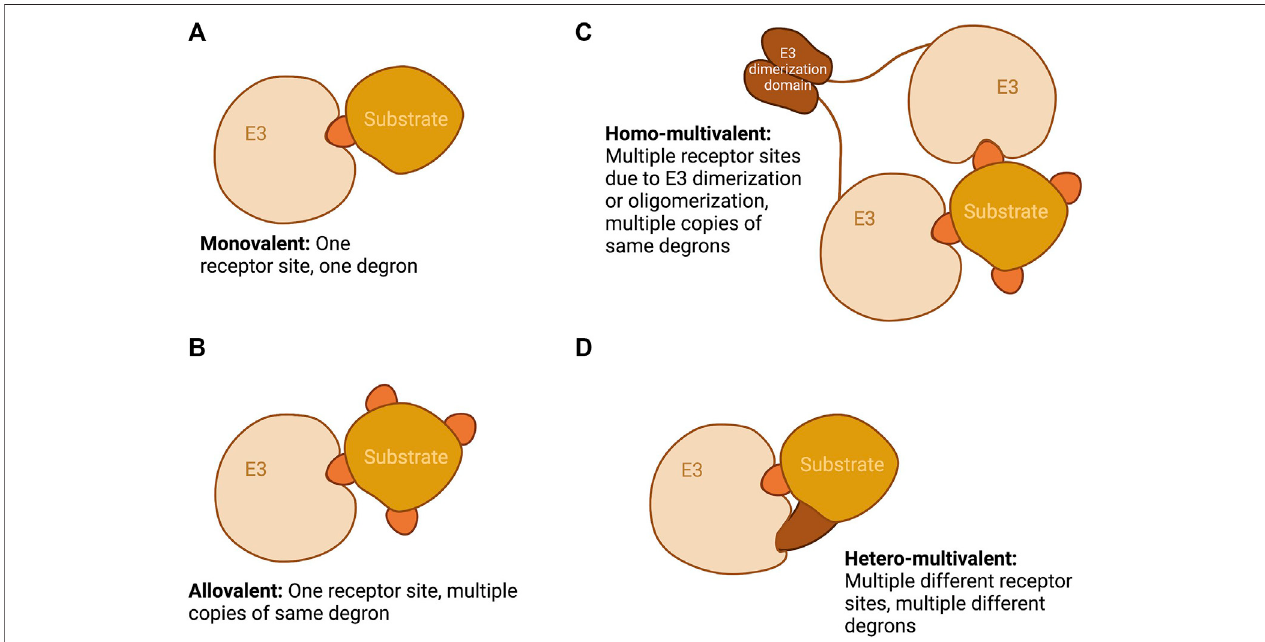
FIGURE 1 | Schematic showing the different modalities of E3-substrate recognition namely: (A) Monovalent, one E3 receptor site and one degron; (B) Allovalent, one E3 receptor site and multiple copies of the same degron; (C) Homo-multivalent, multiple E3 receptor sites as a result of E3 dimerization or oligomerization and multiple copies of the same degron; and (D) Hetero-multivalent, multiple different receptor sites on an E3 subunit and multiple different degrons. Created with BioRender.com.